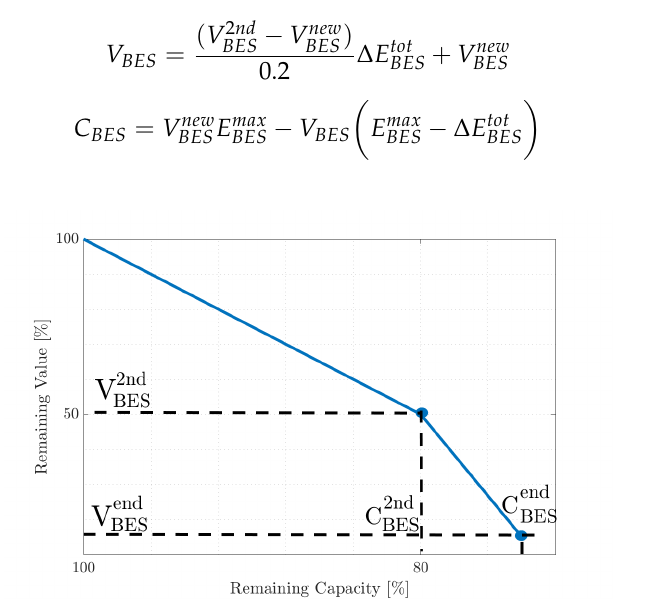
Figure 3. Model of remaining value per kWh as presented in [43]: Here, V 2 nd represent the value at the start of second life, value at the end of its lifetime, capacity at the start of second life, and capacity at the end of lifetime,